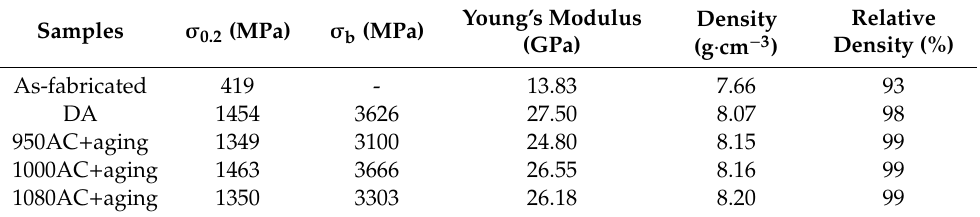
Figure 9. ( a ) The representative compressive stress–strain curves of the SPS IN718 alloys (the inset is the enlarged view of the yielding stage). ( b ) The compressive yield strength and ultimate compressive strength of the IN718 samples. Table 3. Mechanical properties, densities and relative densities of the SPS IN718 alloys after different heat treatments.